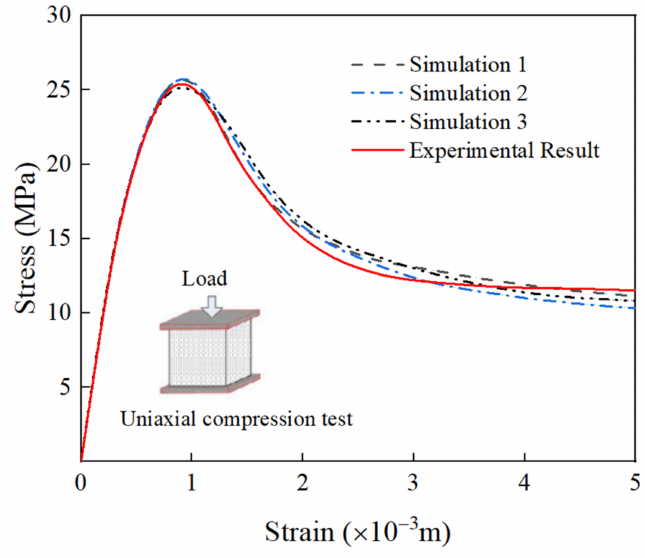
Figure 6. Verification of the meso-model of